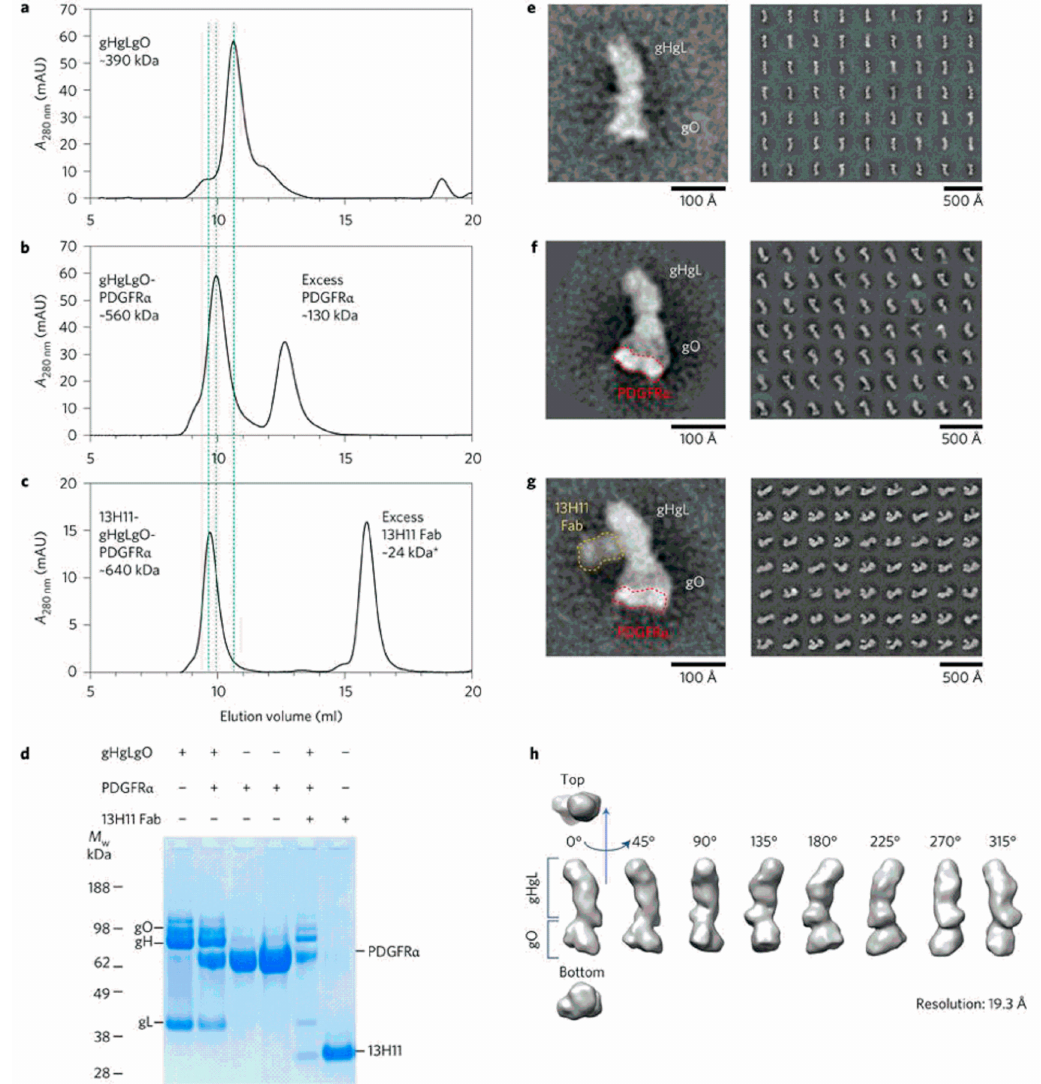
Figure 2. Analysis of the gH / gL / gO-PDGFR α complex. Size exclusion chromatography profile of the gH / gL / gO alone ( a ), or complexed with PDGFR α ( b ), or PDGFR α and the Fab fragment of the anti-gH mAb 13H11 ( c ). The shift in the elution time of ( b ) and ( c ) complexes compared to ( a ) is indicated by vertical dotted lines. (d) SDS-PAGE in reducing conditions of individual proteins and complexes, as indicated. ( e – g ) EM negative staining of gH / gL / gO alone ( e ), complexed with PDGFR α (indicated by a red dotted line) bound to gO ( f ), and with PDGFR α (indicated by a red dotted line) and the Fab of mAb anti-gH 13H11 (indicated by a yellow dotted line) bound to the twisted region of gH ( g ). ( h ) EM 3D map of gH / gL / gO at 19.3 Å resolution (from